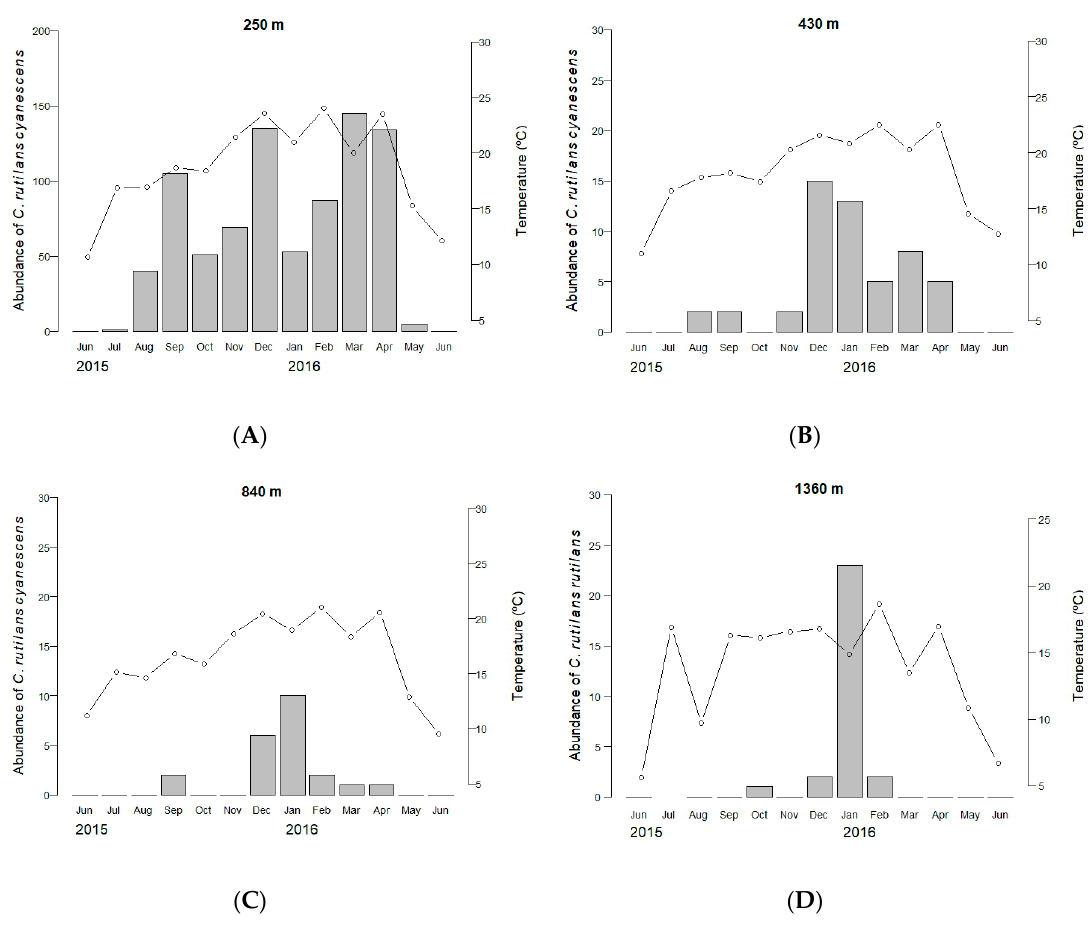
Figure 1. Spatial and temporal distribution of Canthon rutilans cyanescens at ( A ) 250 m, ( B ) 430 m, and ( C ) 840 m; and Canthon rutilans rutilans at ( D ) at 1360 m, taking into account the number of collected individuals (bars), and variation in mean air temperature (circles) during each of the 48 h surveys.